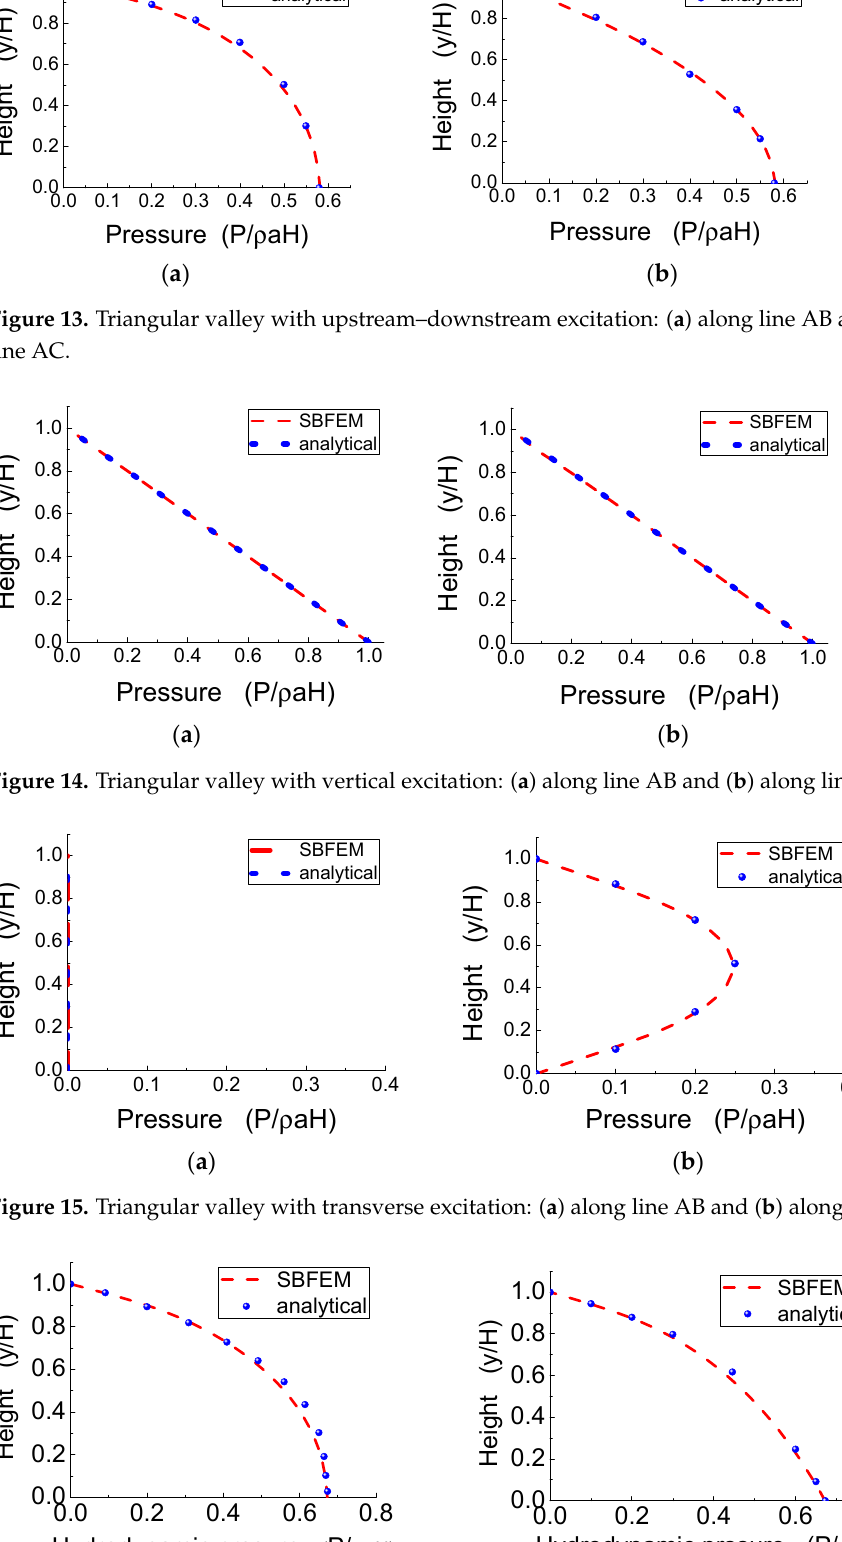
Figure 12. Rectangular valley: ( a ) upstream–downstream excitation and ( b ) vertical excitation.